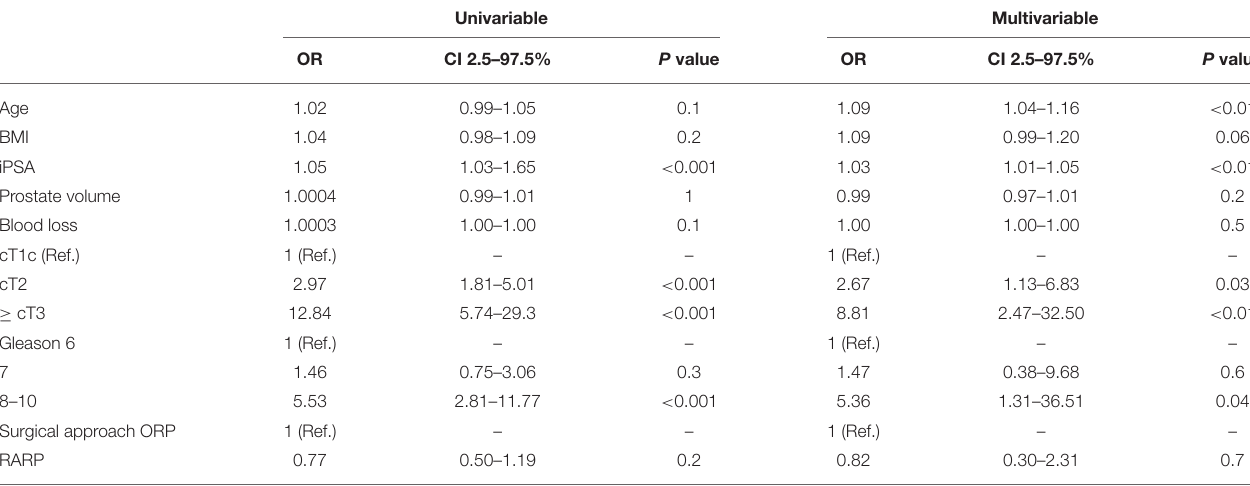
TABLE 5 | Univariable and multivariable logistic regression model predicting unilateral or no Neurovascular Bundle Preservation (NVPB).